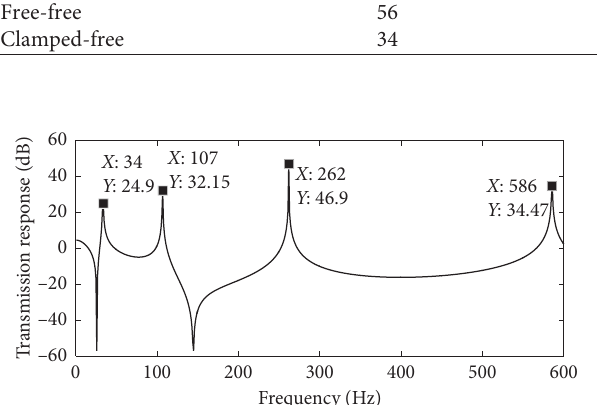
Figure 13: Transmission response of out-of-plane vibration for the curved